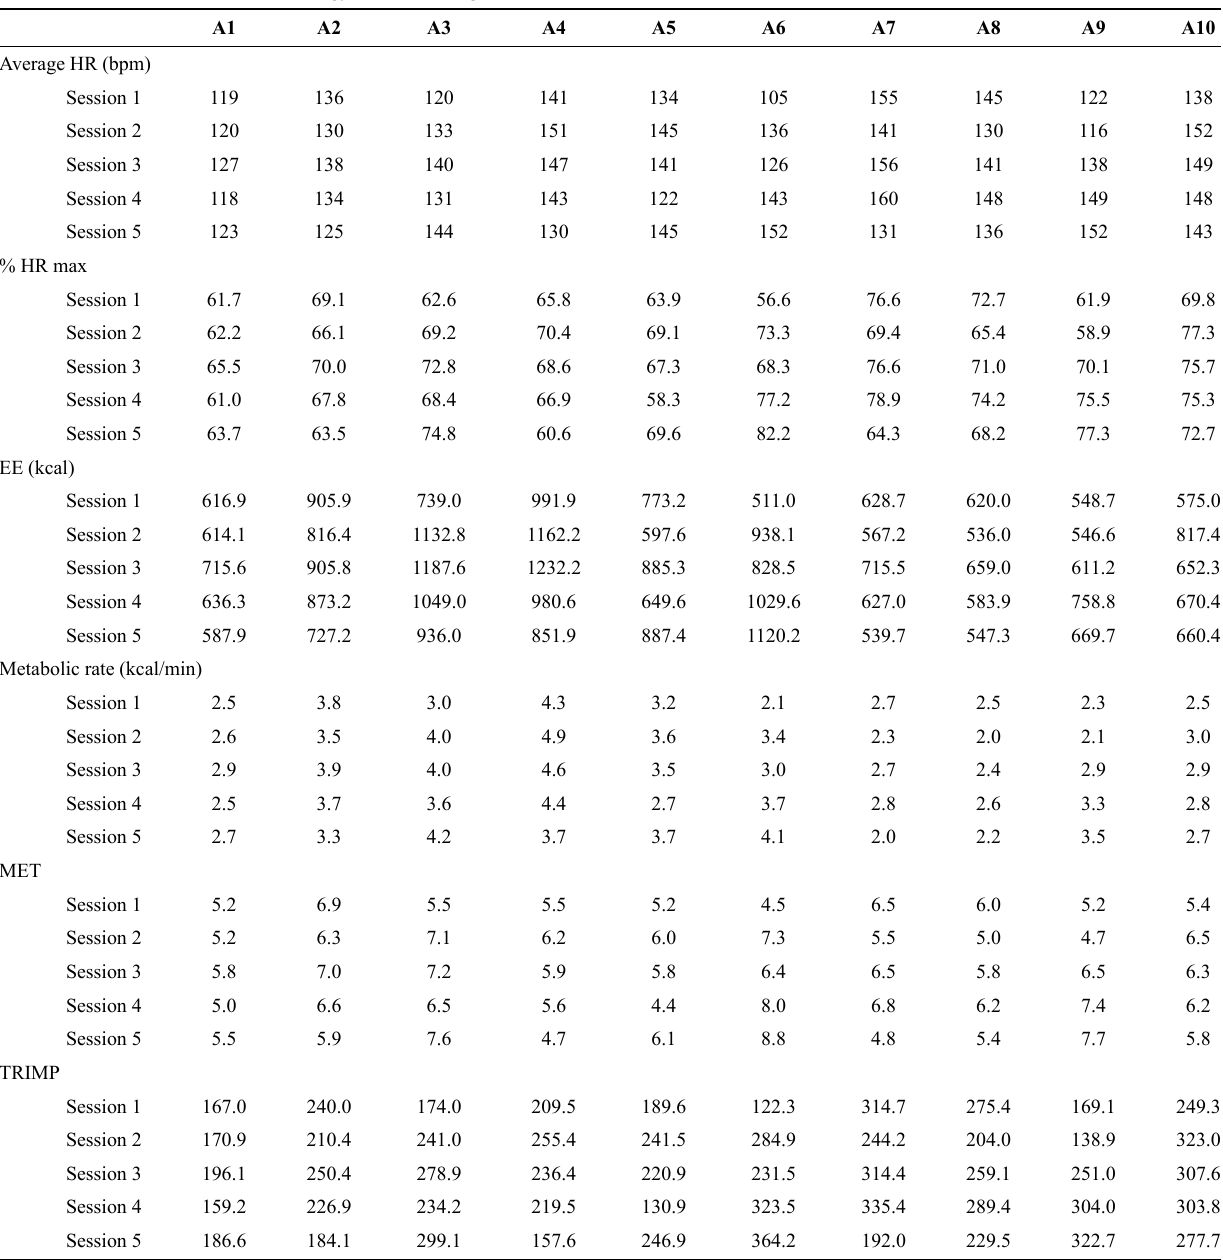
Table 3 - Individual data for each artistic gymnastic training session. A1 A2